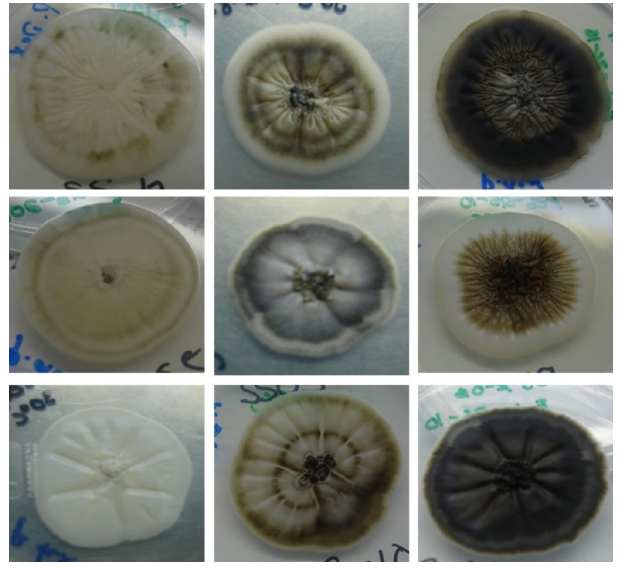
Figure 1. Representative images of colonial morphology of the Sporothrix schenckii complex clinical isolates evaluated in this study.